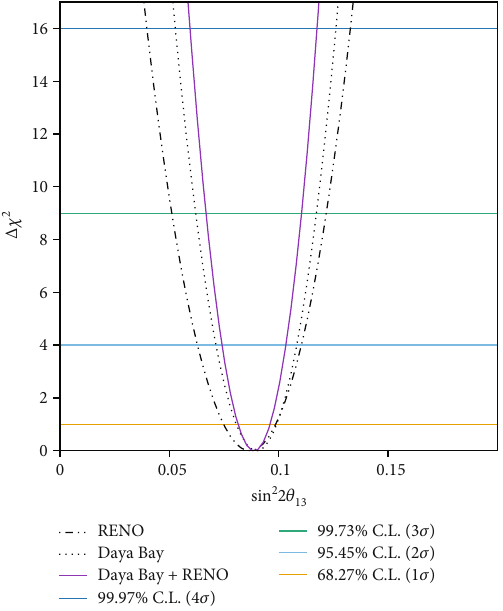
Figure 9: Obtained Δχ 2 distribution for sin 2 2 θ +RENO rate-only combined analysis (full purple line), together with the results from Daya Bay (dotted line) and RENO (dash- dotted line),